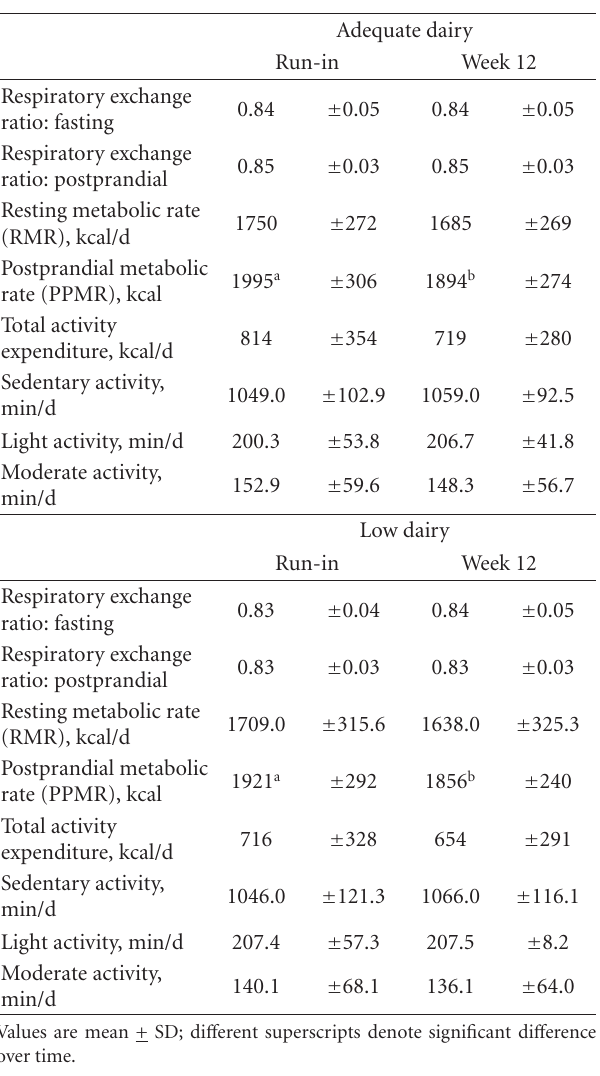
Table 7: Total activity counts per day in women and men consum- ing adequate dairy (AD) or low-dairy (LD) diets for 12 weeks on a caloric-restricted